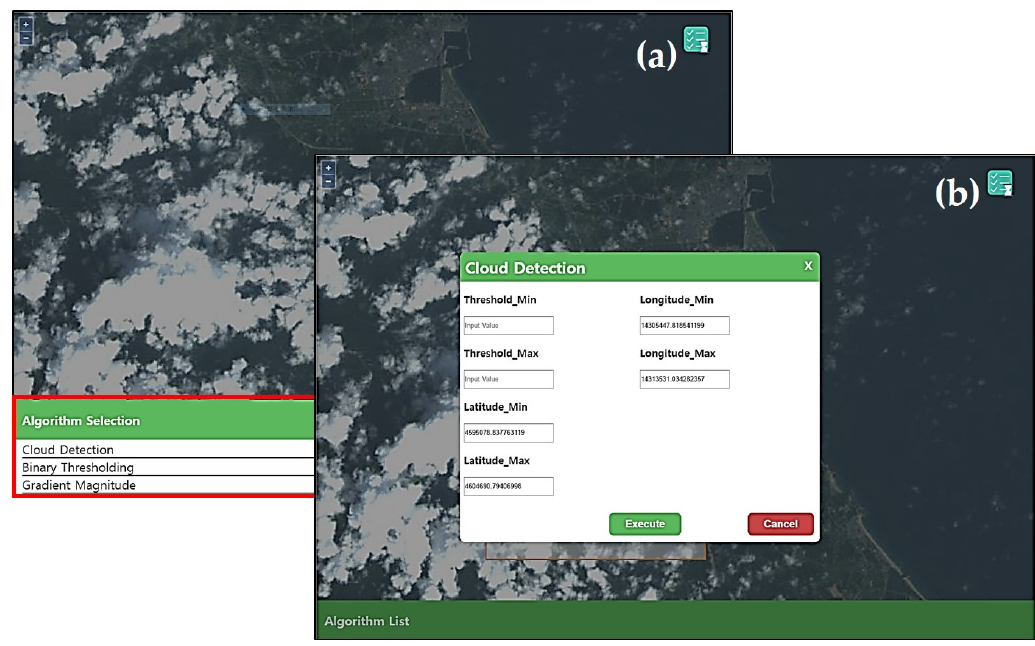
Figure 4. Configuration of the user interface on the client side: ( a ) select algorithm—GetCapabilities request; ( b ) algorithm modal view—DescribeProcess request.